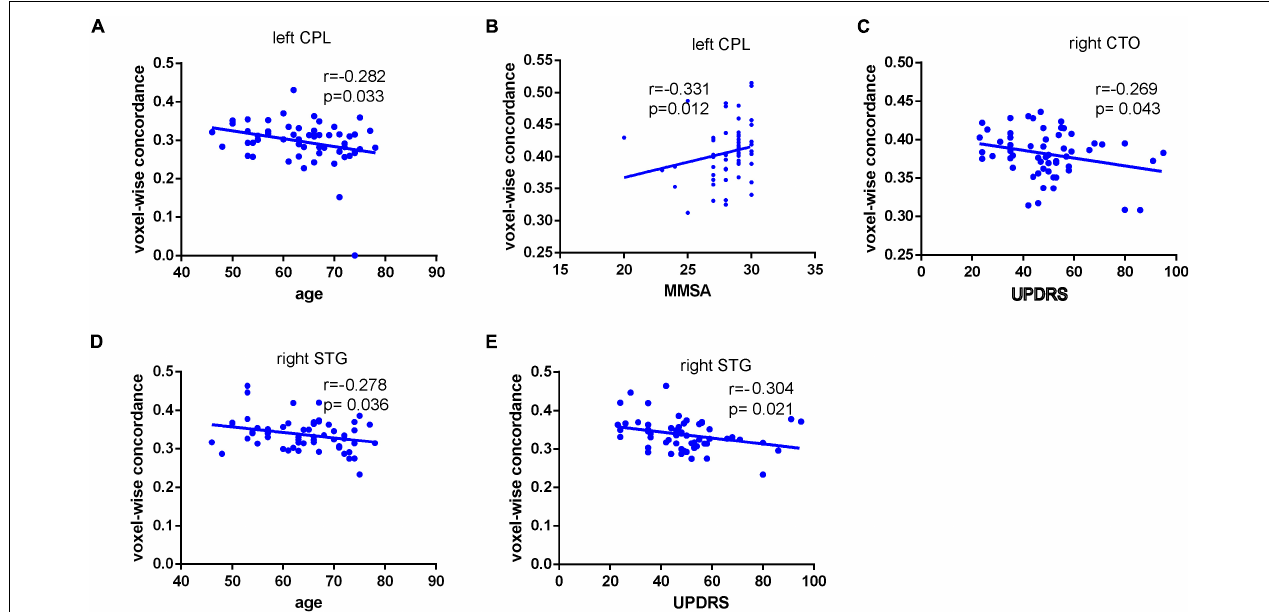
FIGURE 4 | Connection between age/MMSA scores and voxel-wise concordance value in the left CPL in PD patients from HCs ( r = –0.282,0.331; P = 0.033, 0.012). (A,B) Negative correlation between concordance value in the CTO and UPDRS scores ( r = –0.269; P = 0.043). (C) Negative association between age, UPDRS scores, and the concordance value in STG ( r = –0.278, –0.304; P = 0.036, 0.021) (D,E)